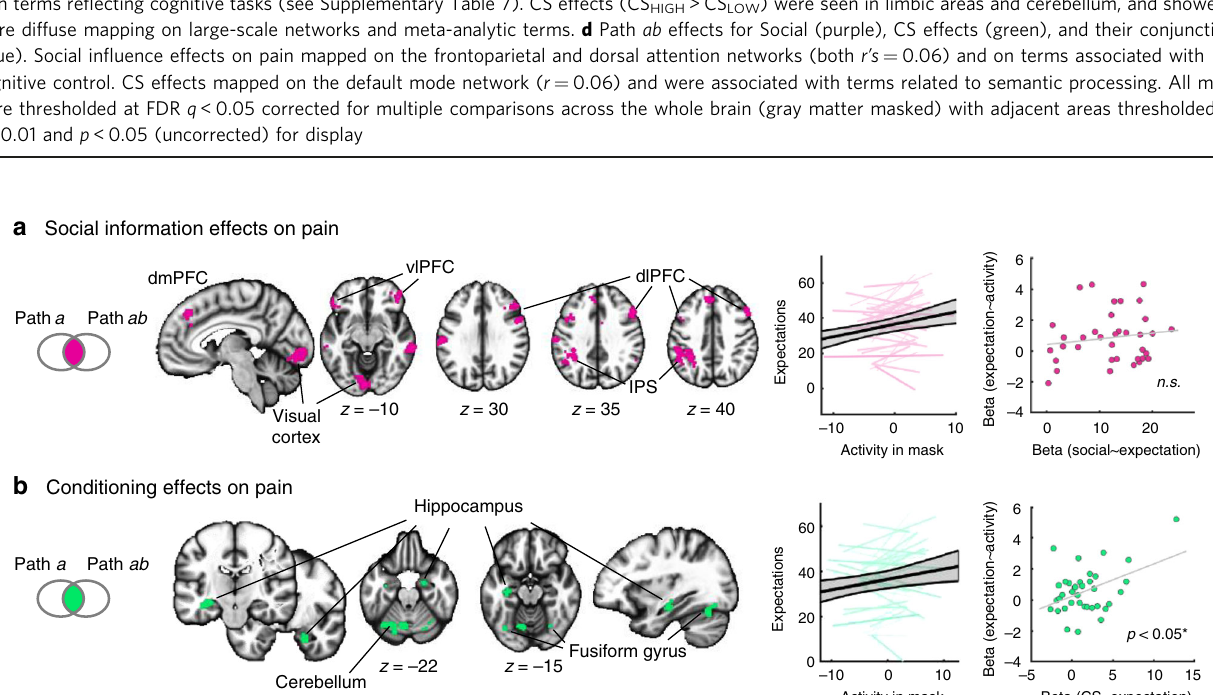
Fig. 3 Conjunction of path a and ab effects. a Social information effects were consistent across paths a and ab in dmPFC, vlPFC, dlPFC, IPS, and visual cortex. Trial-wise average activity (betas) in these regions correlated signi fi cantly with trial-wise expectation ratings (individual slopes in purple). Average activity did not signi fi cantly predict individual differences in the social in fl uence effects on expectations (scatter plot). b CS effects were consistent across paths a and ab in the hippocampus, cerebellum, and fusiform gyrus. Trial-wise average activity in these areas correlated signi fi cantly with trial-wise expectation ratings (individual slopes in green). Individual differences in the strength of the activation were correlated with individual differences in how much expectations ratings were driven by the CS. Conjunction effects are displayed as the intersection of activation for paths a and ab , each of them thresholded at P < 0.05 FDR-corrected and adjacent voxels at p < 0.05 uncorrected. Asterisk re fl ects signi fi cant Pearson correlation coef fi cient ( p < 0.05). Shaded error bands re fl ect bootstrapped 95% con fi dence intervals. Source data are provided as a Source Data fi